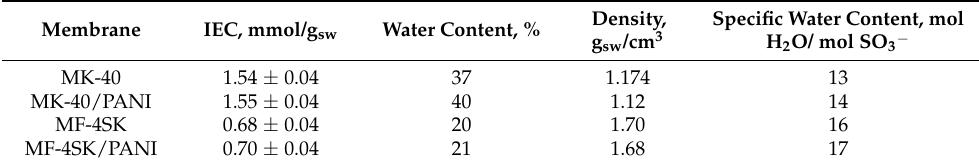
Table 1. The physical-chemical properties of the initial and modified membranes. Membrane